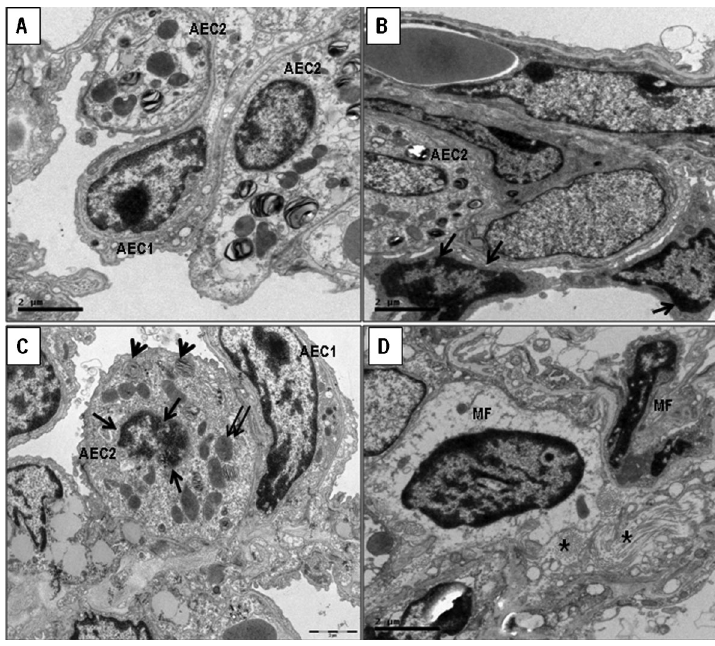
birefringence of collagen V (Figure 5G-I).